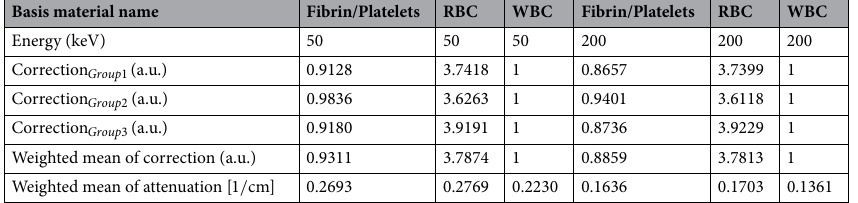
Correction Group 1 (a.u.) Correction Group 2 (a.u.) Weighted mean of correction (a.u.) Weighted mean of attenuation [ 1 / cm Table 2. Correction factors of the attenuation coefficients for the basis materials fibrin/platelets, RBC and WBC. This is listed separately for each group consisting of four measured clots. The lower part of the table shows the final resulting attenuation properties considering the correction factors above. Furthermore, the mean value of the groups weighted by the inverse cost function value is listed. The values of the cost function were 0.9‰ for group one, 1.4‰ for group two and 0.8‰ for group three rounded to the fourth digit.